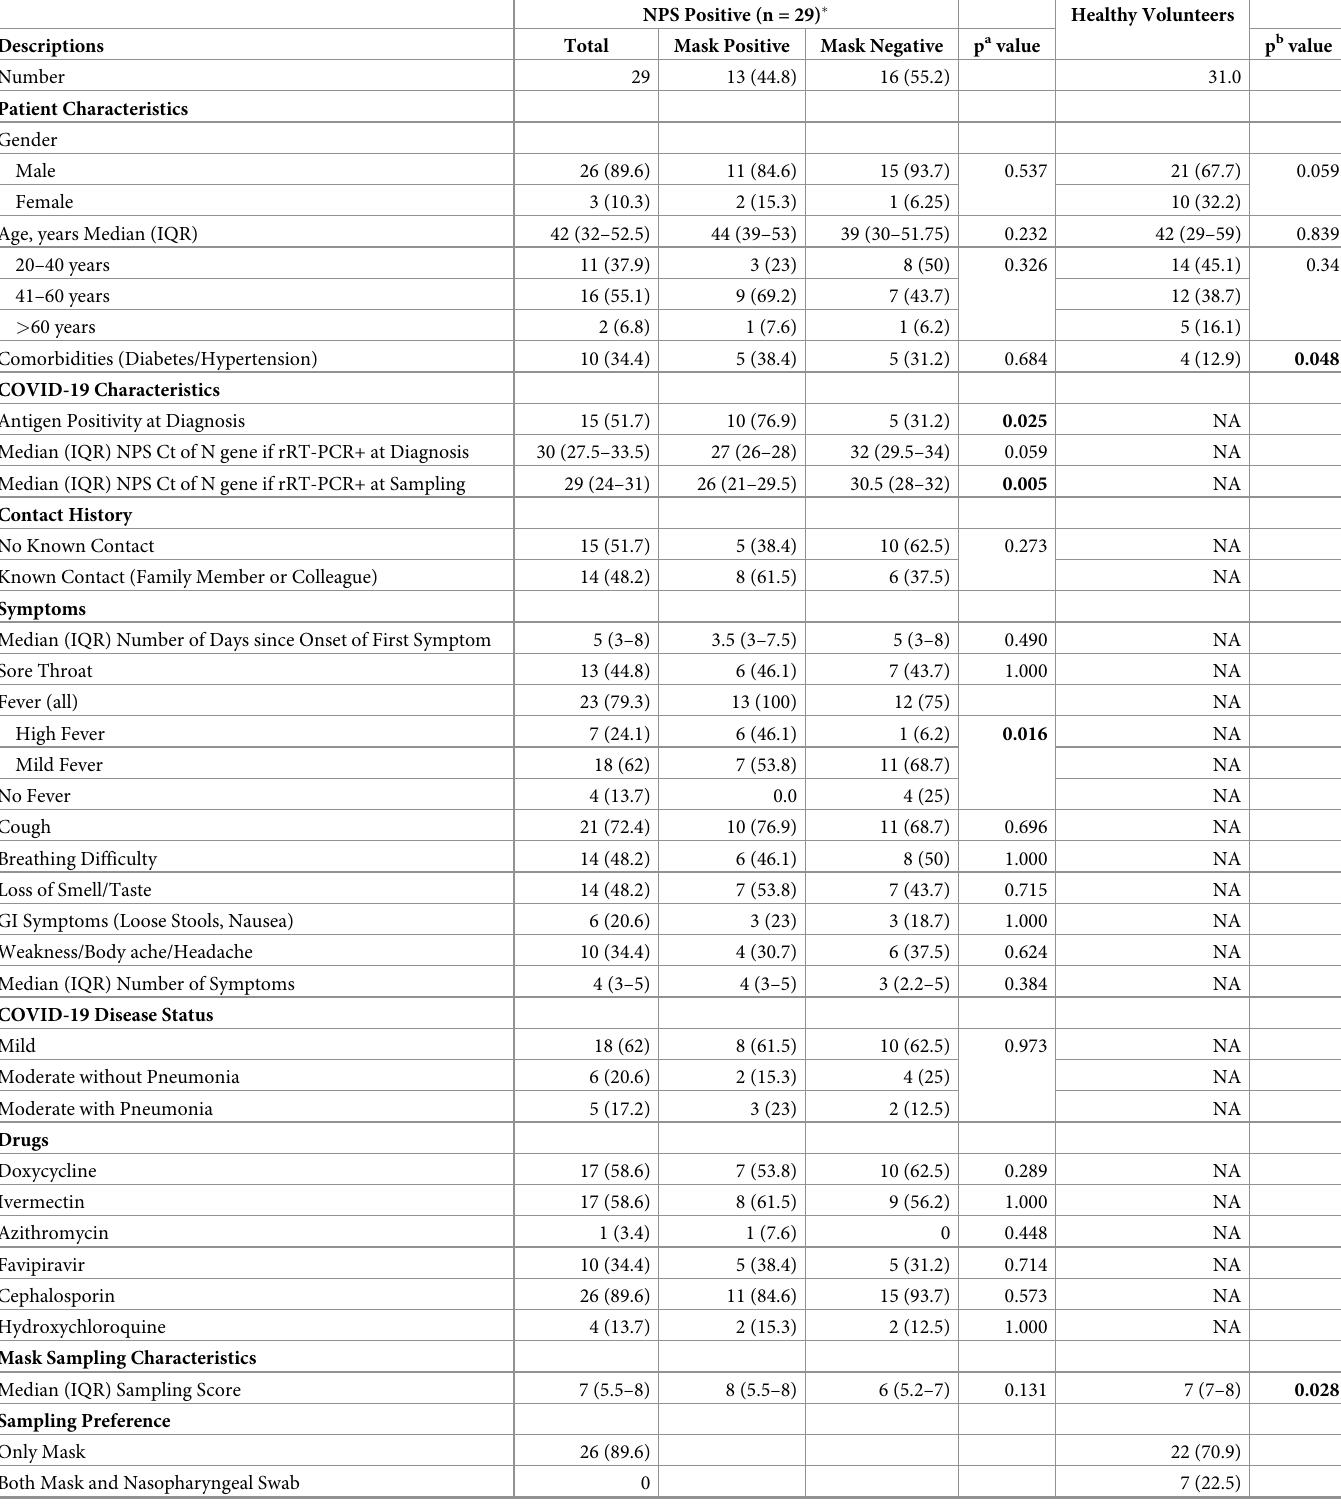
Table 1. Comparison of nasopharyngeal swab Ct, symptoms, treatment and mask sampling characteristics among mask positive and mask negative